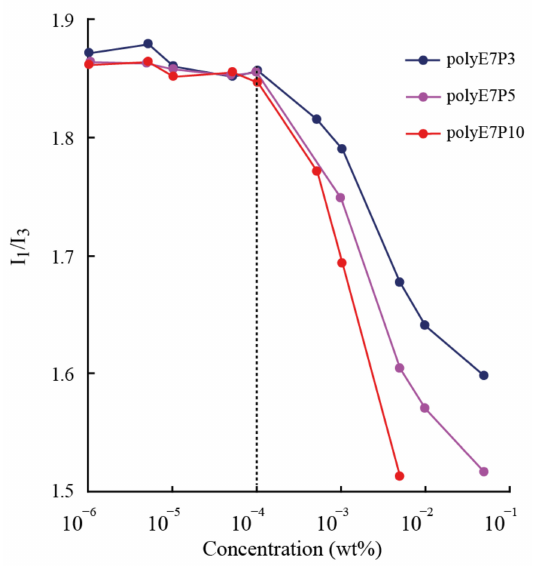
Figure 3. I 1 / I 3 ratio of the vibronic band intensities of pyrene as a function of a polymer